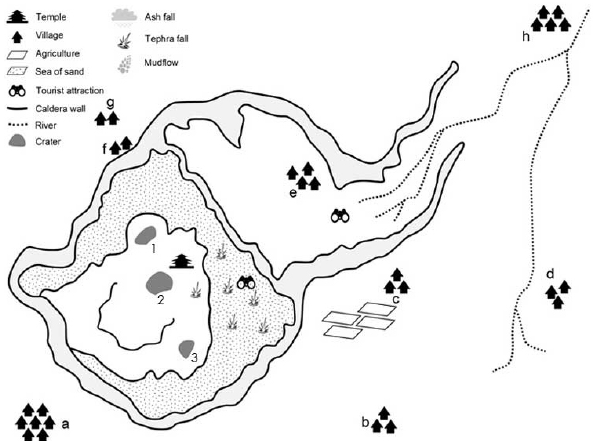
Figure 5. Human–volcano system at Bromo Volcano. (1) Mt. Ba- tok, (2) Bromo Volcano, (3) Mt. Kursi, (a) Ngadas Village, (b) Ranupane Village, (c) Ngadirejo Village, (d) Sumber Village, (e) Ngadisari Village, (f) Wonokitri Village, (g) Tosari Village, (h) Wringinanom